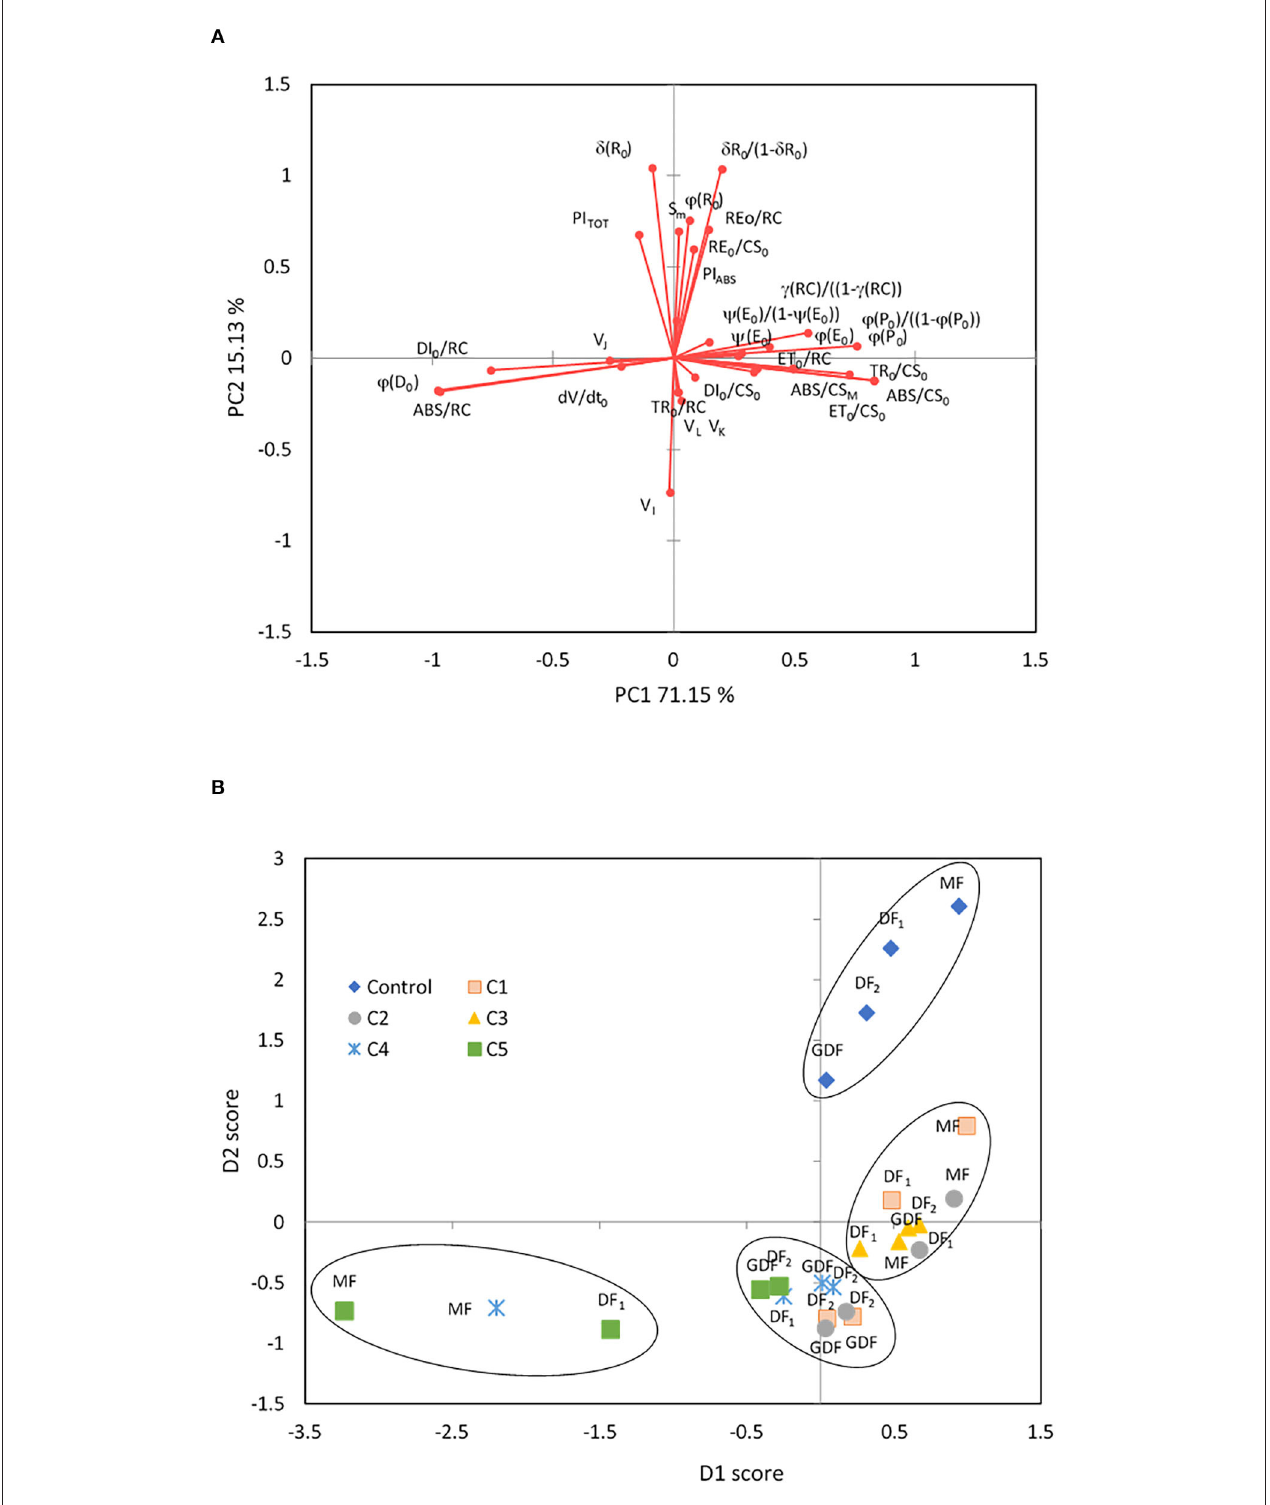
FIGURE 5 | Principal component analysis of 31 Chl fluorescence parameters in control and response to Cd treatment from 7 (C1) to 111 µ M (C5) after 72h of exposure. Principal component 1 (PC1) accounted for 71.2 % of the variance. Principal component 2 (PC2) accounted for 15.1 % of the variance. (A) Factor loadings on the first two principal components (PCs) are shown after oblique (direct oblimin) rotation. (B) The two PC projections after oblimin rotation with factor scores are sorted by frond age and Cd concentrations. Plotted points belong to centroids of differently aged plant fronds (MF, mother frond; DF 1 , first daughter frond; DF 2 , second daughter frond; GDF, granddaughter